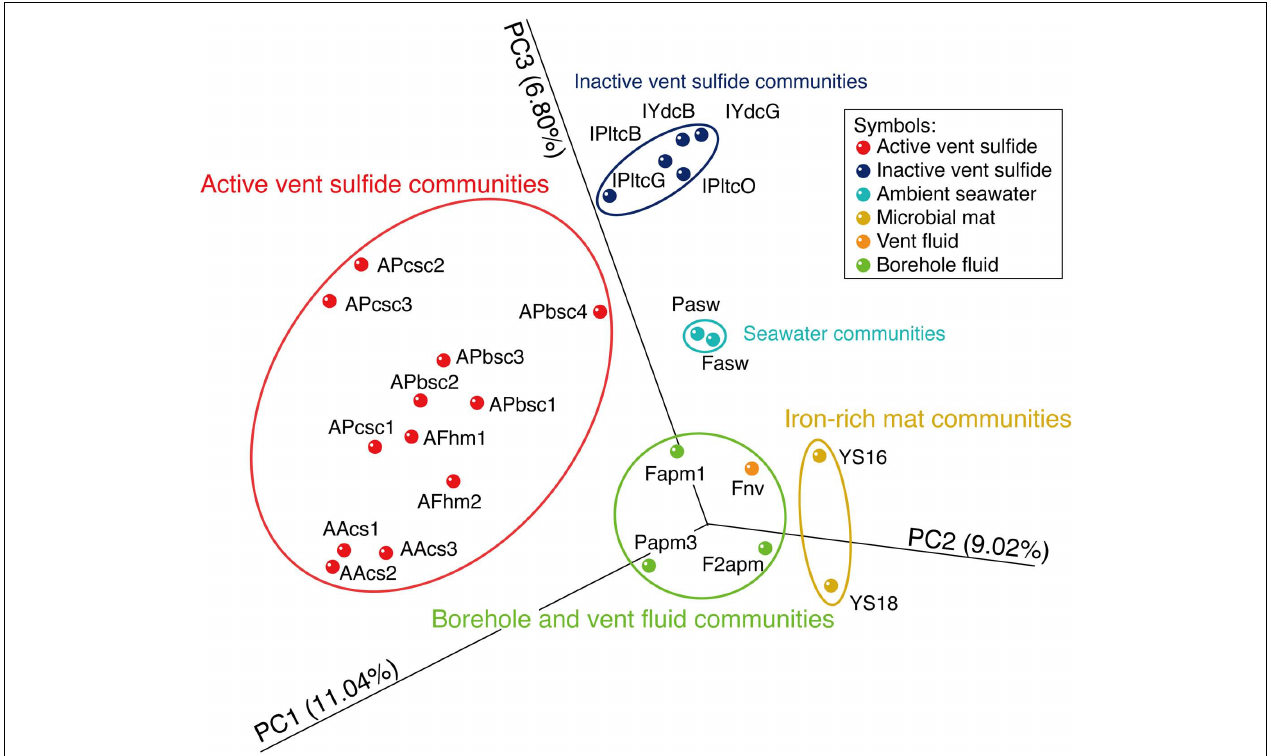
270˚C fluid at the Pika site; APcsc1-4, clear smoker chimney venting 19˚C fluid at the Pika site; IPltcB, G, and O, inactive chimney at Pika site; IYdcB, and G, inactive chimney at theY site; Pasw, and Fasw, ambient seawater at the Pika and Snail sites, respectively; Fapm1 and F2apm, borehole fluids at the Snail site collected in 2004 and 2005, respectively; Papm3, borehole fluids at the Pika site; Fnv, natural vent fluid at the Snail site;YS16 andYS18, iron-rich mats at the Kaiko and Snail sites, respectively.The data from theY and Kaiko sites are not mentioned in the present paper (please, see Kato et al., 2009a, 2010 for details).